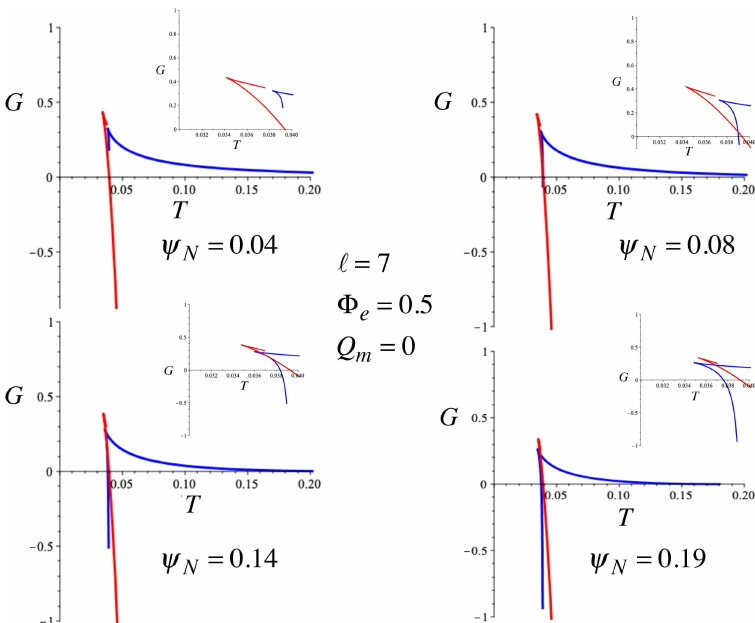
Figure 21 . Fractured Cusp Development at fixed electric potential. This sequence of plots of free- energy vs. temperature show the development of the fractured cusp as ψ ( I ) magnetic charge. The blue curve is the negatively charged branch; the insets highlight the relation- ship between the negative and positive branches. Here ‘ = 7 and Φ e = 0 . 5